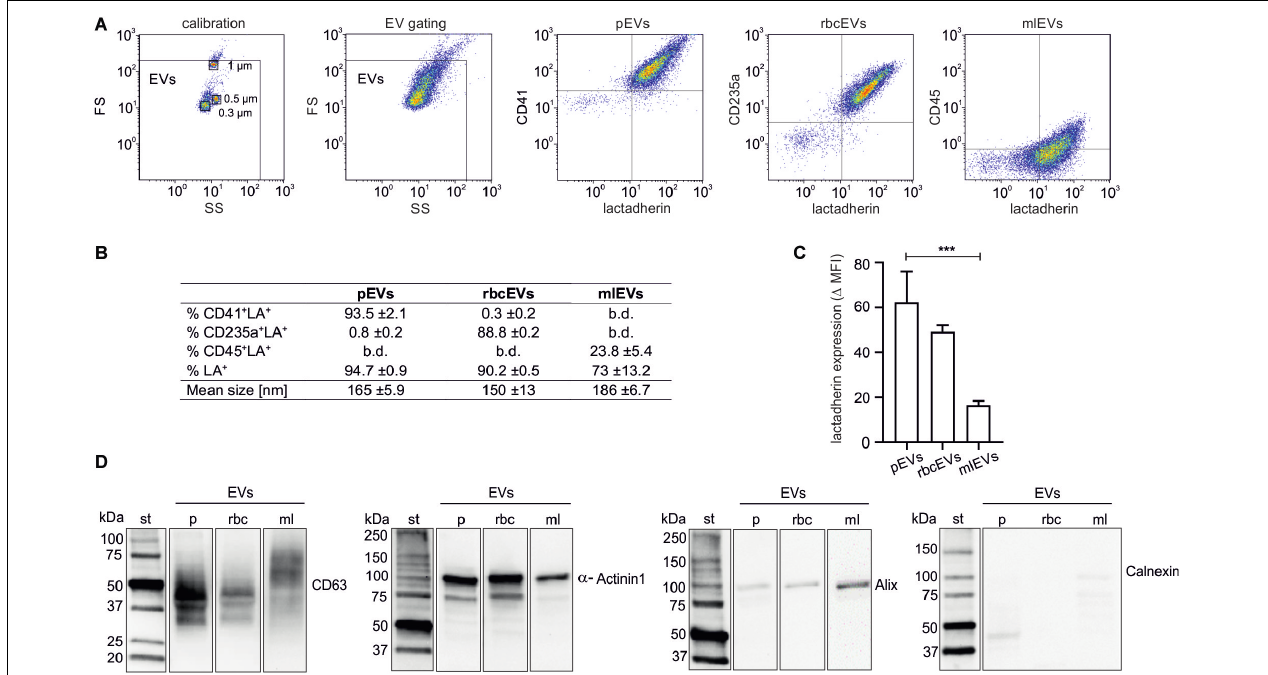
FIGURE 1 | Characterization of extracellular vesicle fractions. EVs were isolated from platelet concentrates (pEVs), red blood cell concentrates (rbcEVs), or from monocytic THP-1 cells (mlEVs). Characterization of isolated EV fractions was performed using flow cytometry, nanoparticle tracking analysis, and Western Blotting, as described in the section “Materials and Methods.” (A) Flow cytometric characterization of EVs was performed after calibration with fluorescent silica beads. EVs were defined as phosphatidylserine-exposing (i.e., lactadherin-positive) events in the EV gate, and their cellular origin was assessed using CD41, CD235a, and CD45 as markers for pEVs, rbcEVs, and mlEVs, respectively. (B) Exposure of markers of cellular origin ( n = 10) and mean size of pEVs, rbcEVs, and mlEVs ( n = 11); b.d., below detection. (C) Difference between the specific antibody staining and the respective fluorochrome-labeled reagent control (median fluorescence intensity, MFI) for lactadherin staining. Significance (*** p ≤ 0.001) was calculated for pEVs vs . mlEVs ( n = 10); as only two batches of rbcEVs were available, significance cannot be indicated for rbcEVs vs . mlEVs. (D) Characterization of pEVs, rbcEVs, and mlEVs using Western blotting (10 µ g of protein per lane). The blot images are presented as grouped images from different parts of the same membrane or from different membranes. The original blots are available online as Supplementary Datasheet S2 of the Supplementary Material . b.d., below the limit of detection.